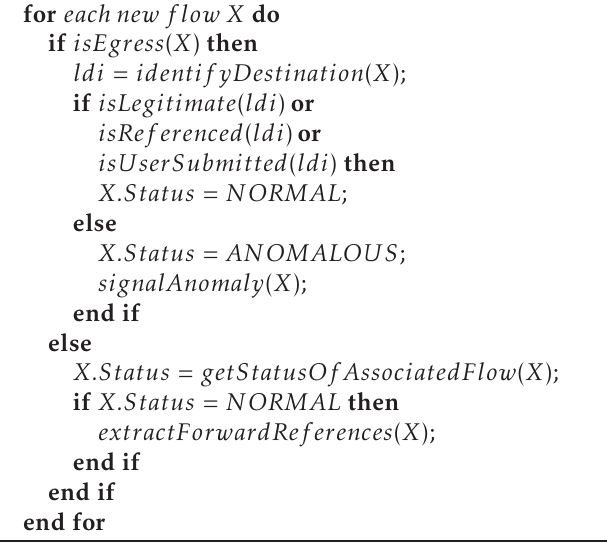
Algorithm 1 UDI detection